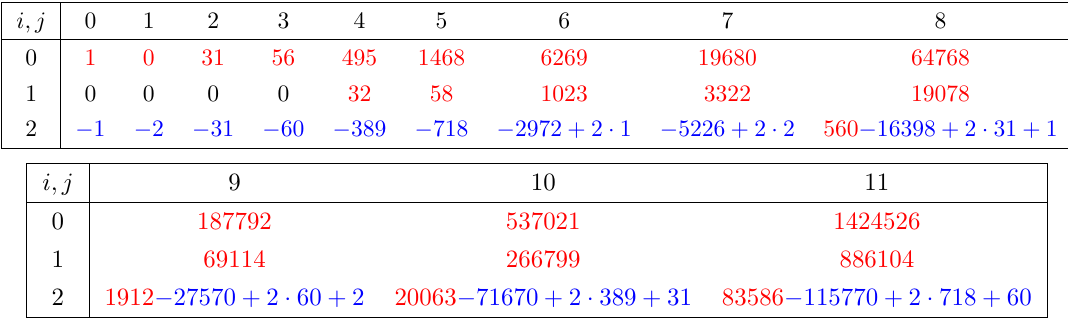
Table 15 . Series coe(cid:14)cients c SO(8)